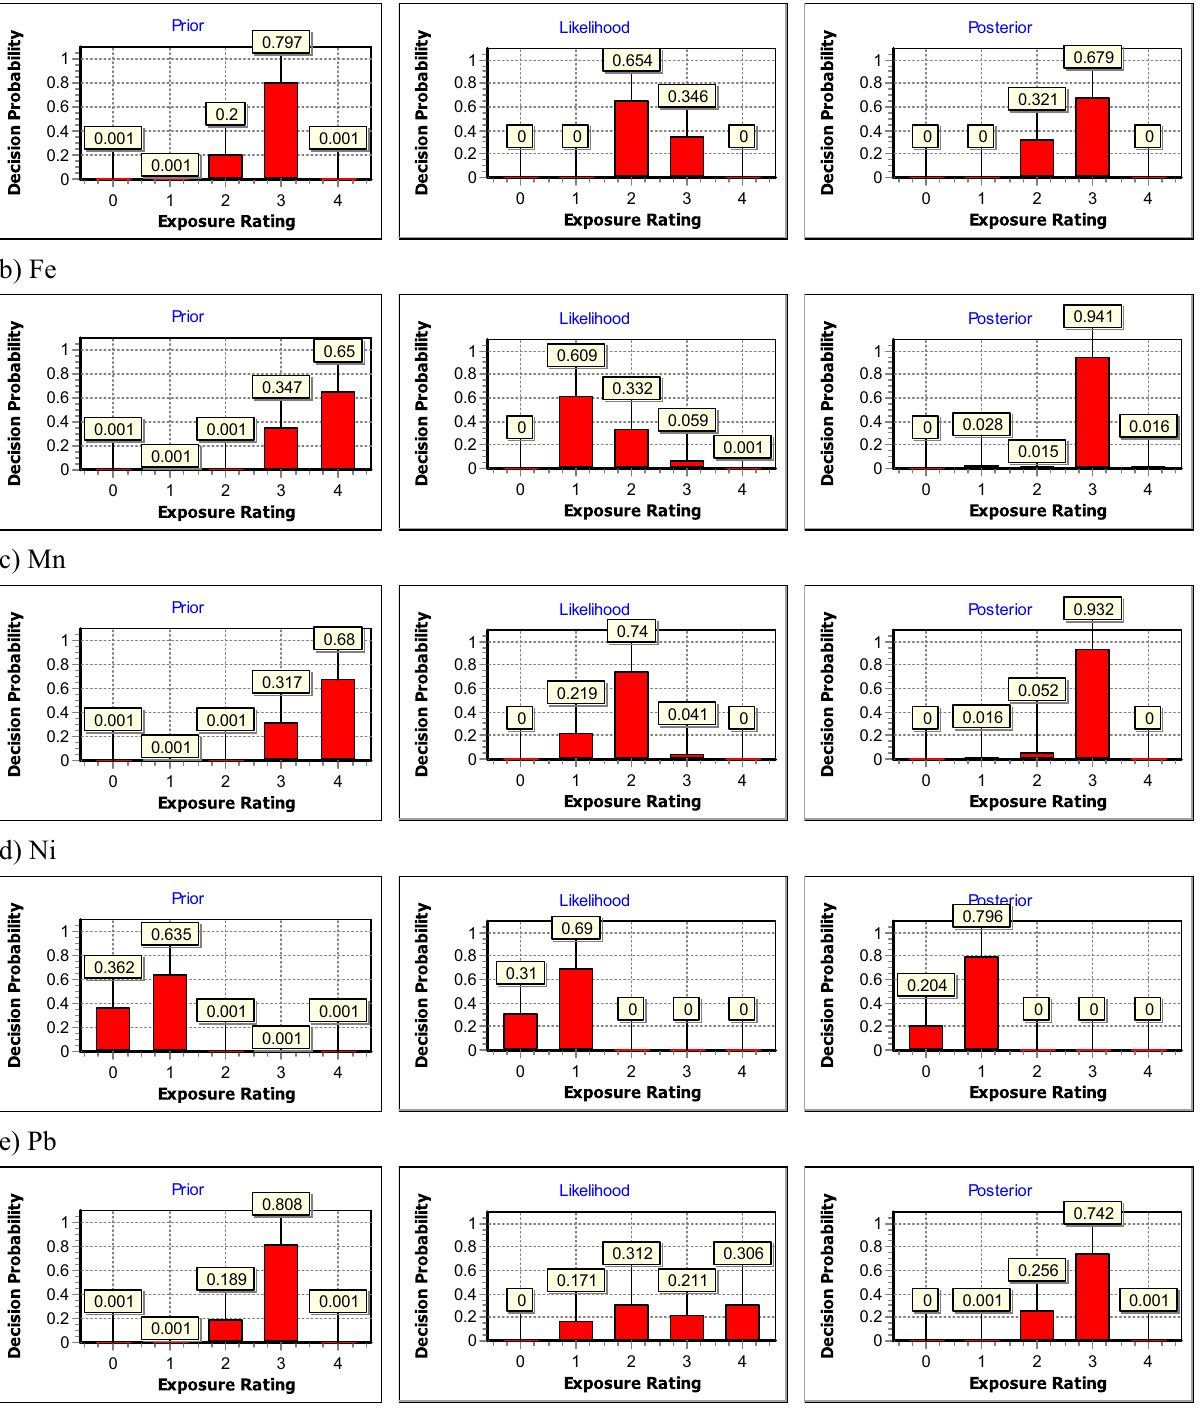
Figure 3. The resultant prior, likelihood, and posterior distributions for ( a ) Cr, ( b ) Fe, ( c ) Mn, ( d ) Ni, and ( e ) Pb fume concentrations in FF region,